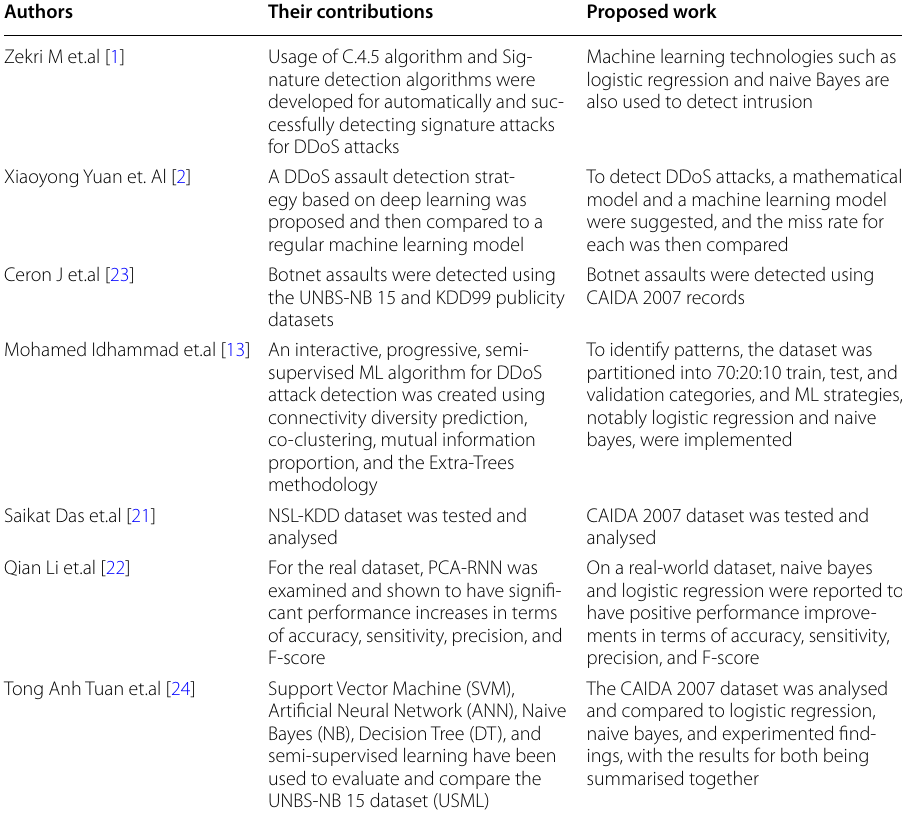
Table 1 An overview of the contributions Authors Their contributions Proposed